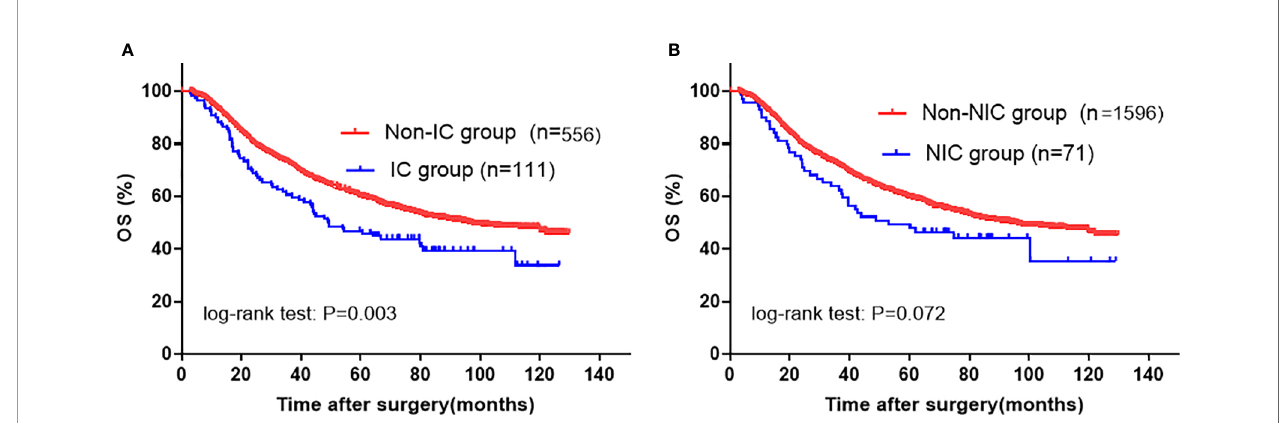
FIGURE 3 | Kaplan-Meier survival analysis according to speci fi c SC in entire cohort. (A) IC; (B) NIC. The signi fi cance of the difference between survival curves was calculated by the log-rank test. SC, severe complication; IC, infectious complication; NIC, non-infectious complication.